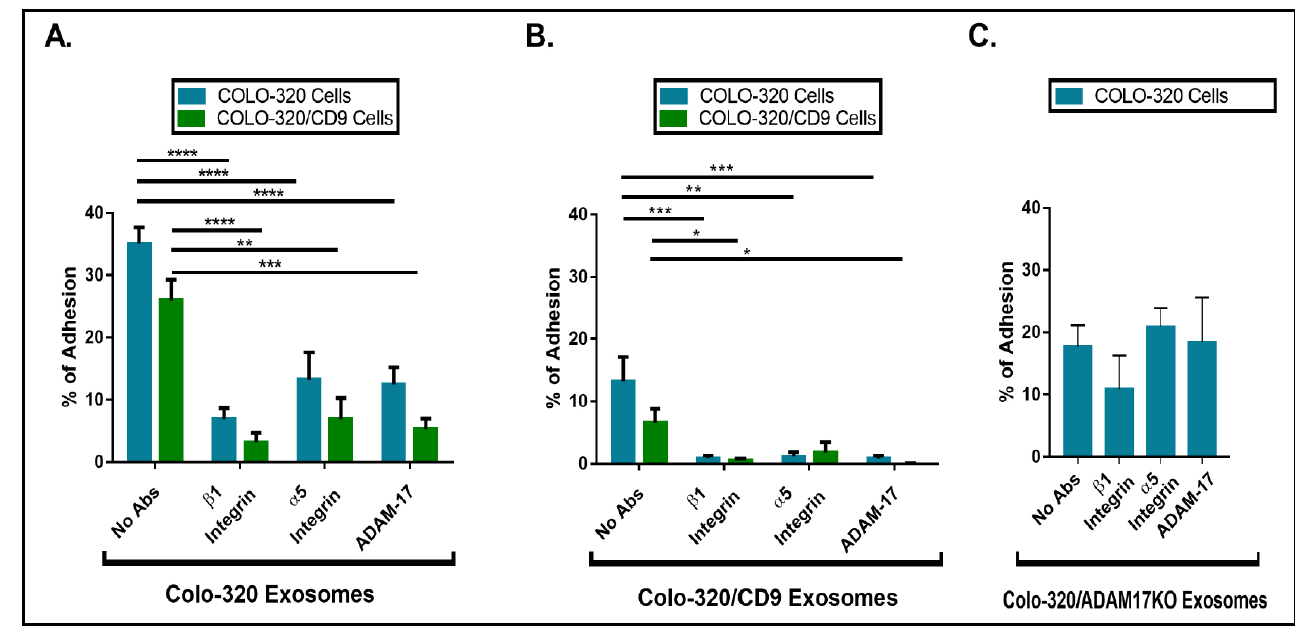
Figure 4. The presence of CD9 reduced cell adhesion to immobilized exosomes that was mediated by cellular integrin α5β1 and exosomal ADAM17. Cell adhesion of Colo-320 or Colo-320/CD9 to exosomes produced by Colo-320 cells ( A ), Colo-320/CD9 cells ( B ), and Colo-320/ADAM17-KO cells ( C ). Cells were stimulated with phorbol ester PMA (200 ng/mL) for 1 h, loaded with the fluorescent probe BCECF-AM and then allowed to adhere to immobilized exosomes (5 µ g of exosomal protein per well) for 60 min at 37 °C under physiological conditions of Ca 2+ /Mg 2+ (0.5 mM/1 mM, respectively). The percentage of cells that remained adhered is indicated as mean ± SEM of four experiments, performed in duplicates. Statistical analysis performed was two-way ANOVA. * p < 0.05, ** p < 0.01, *** p < 0.001, **** p < 0.0001.